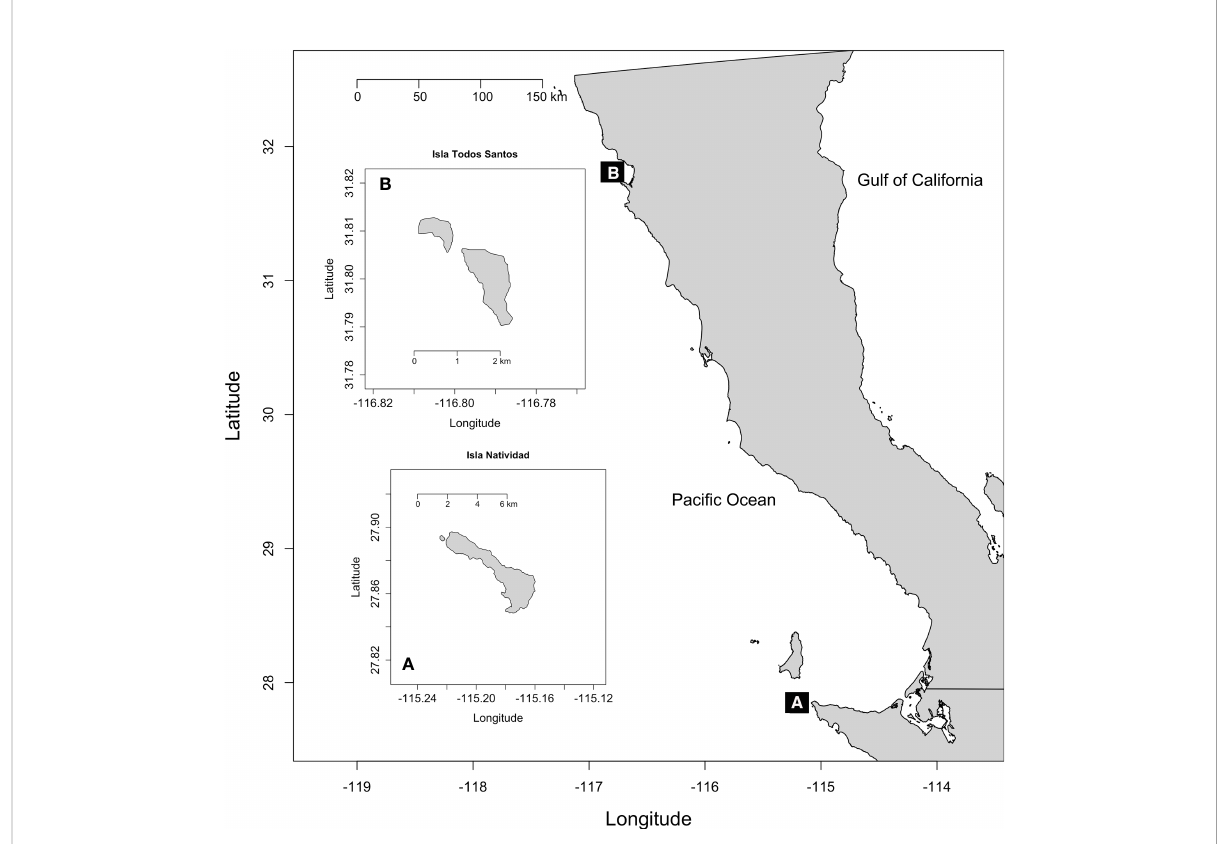
FIGURE 1 Map of the study area including Isla Natividad (inset map A ) and Isla Todos Santos (inset map B